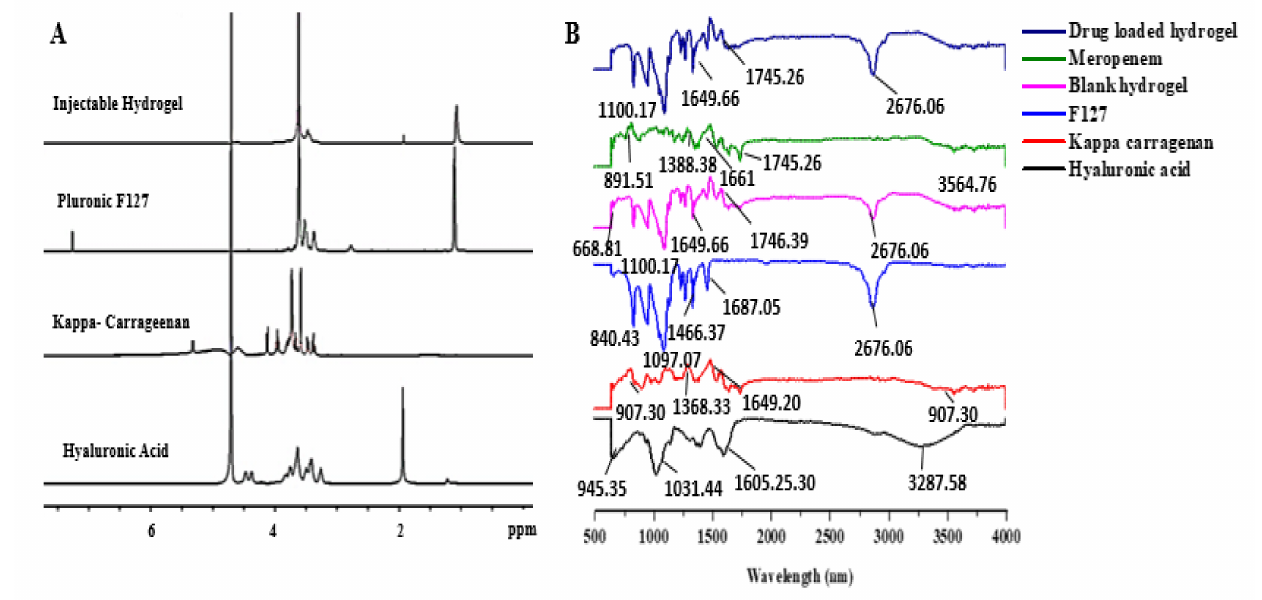
Figure 1. ( A ) 1 H NMR spectra of the injectable hydrogel, κ -carrageenan, F127, and hyaluronic acid; ( B ) FTIR spectrum of the drug-loaded hydrogel, meropenem, blank hydrogel, F127, κ -carrageenan, and hyaluronic